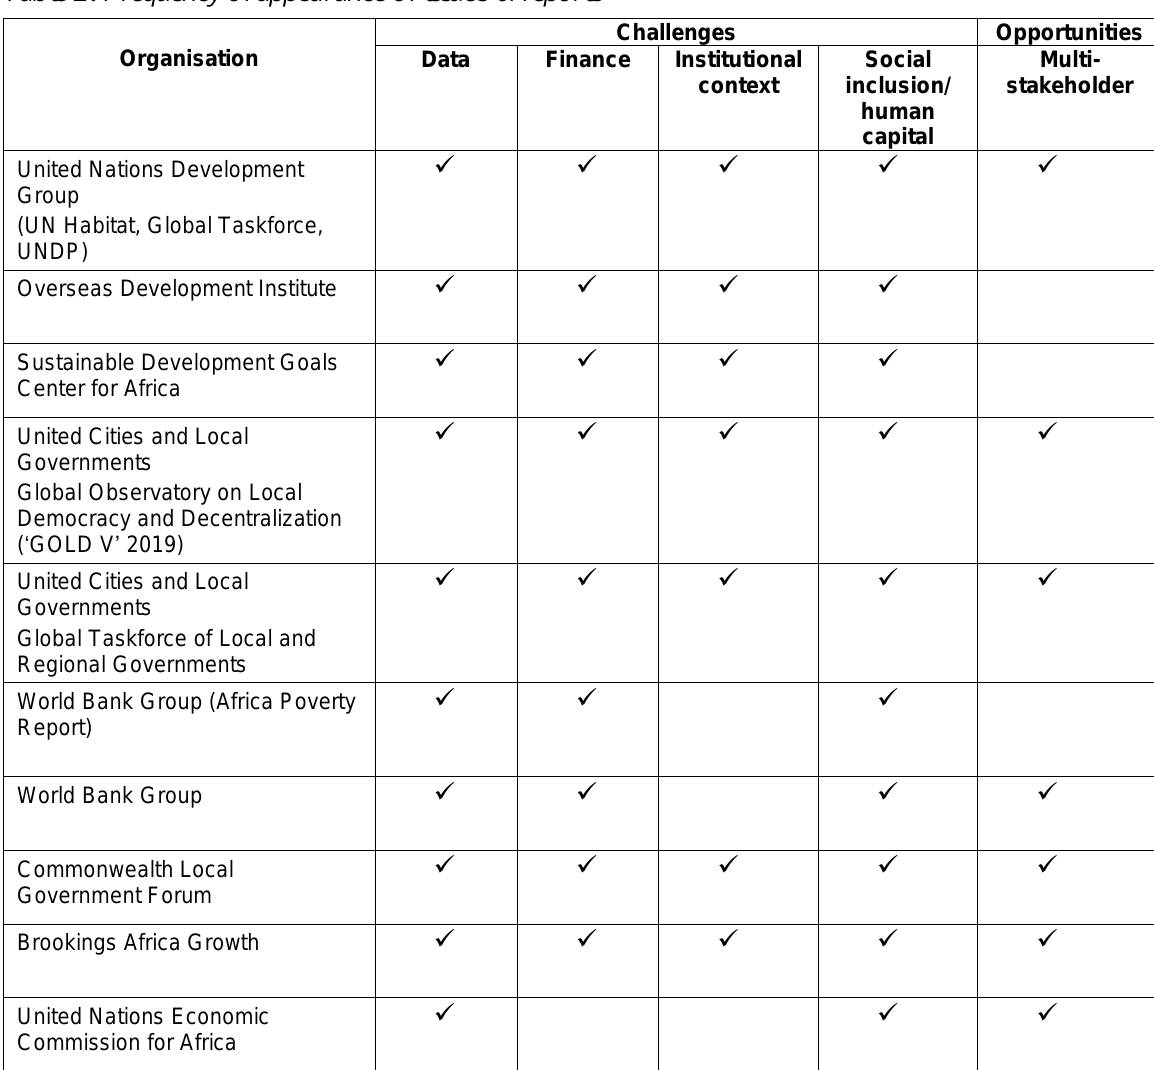
Table 2: Frequency of appearance of issues in